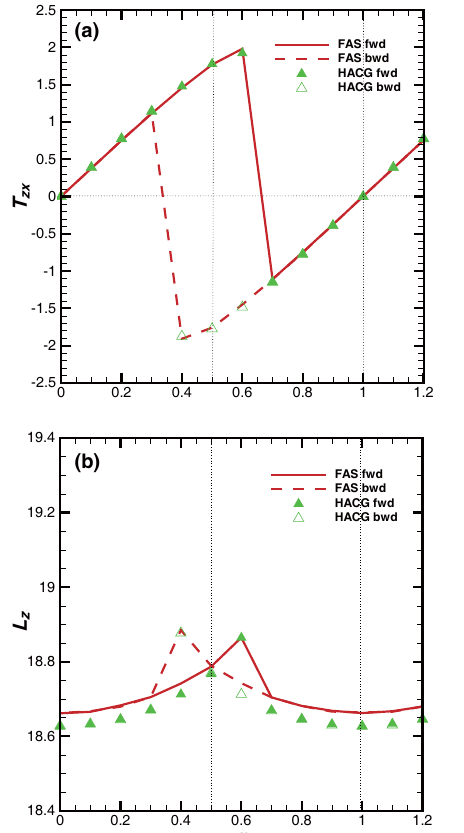
T = –1.0 1 9    , T = 0.15, and Fig. 7 Shear stress profiles at fs zz are generated in the fully atomistic and multi-scale simulations. The fully atomistic profile (forward, with a solid line; backward, with a dashed line) and multi-scale profile (forward, with filled triangles; backward, with hollow triangles).